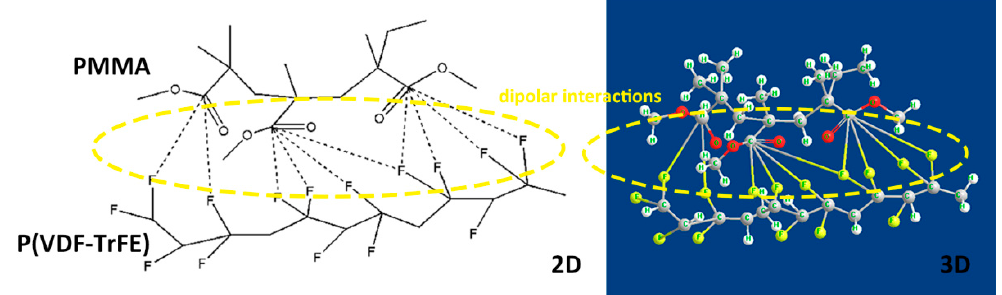
Figure 7. ( a ) Weibull plots of the breakdown strength for blended films and pristine films; ( b ) characteristic breakdown strength of blended films (S1: PVT/PMMA1, S2: PVT/PMMA2, S3: PVT/PMMA3, S4: PVT/PMMA4, S5: PVT/PMMA5, S6: PVT/PMMA6) and pristine films.